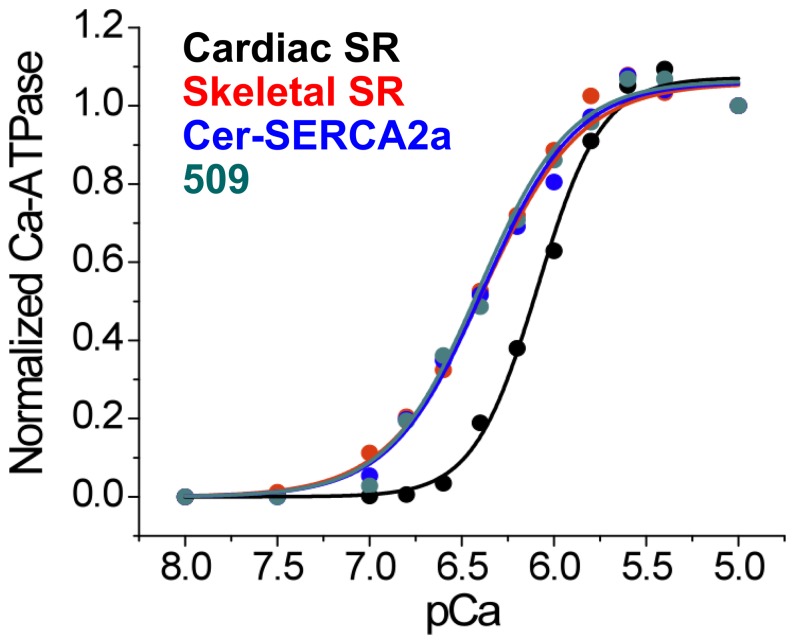
Calcium-dependent ATPase activity of Cer-SERCA2a and 2-color SERCA (construct 509) measured in cell homogenates.The Ca-sensitivity was indistinguishable from that of skeletal SR (red) and greater than that of cardiac SR (black), presumably due to the presence of phospholamban in the latter. The specific ATPase activity (ATP hydrolyzed per s per SERCA2a at 37°C) at saturating Ca2+ (pCa 5.0) was indistinguishable for cardiac SR, Cer-SERCA2a, and 2-color SERCA.